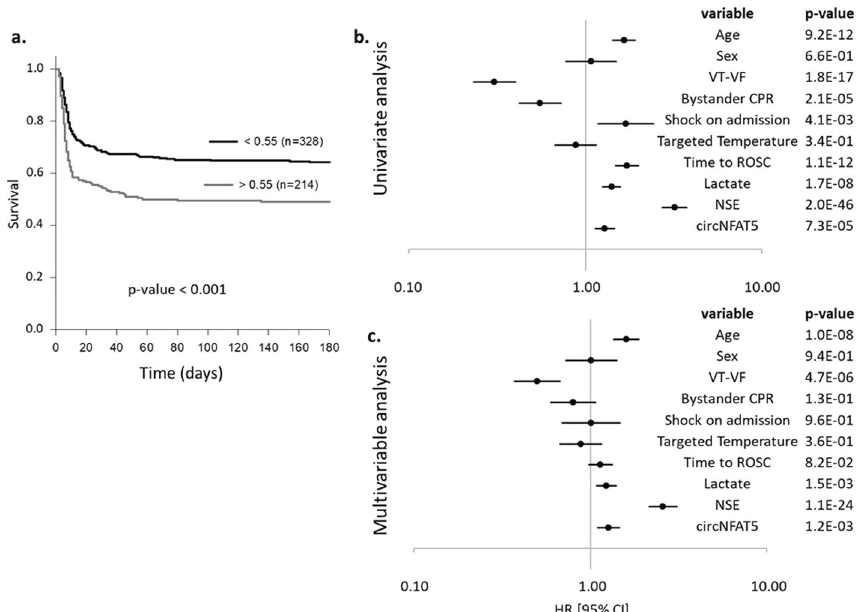
Fig. 5 Survival analyses in TTM‑trial patients at 6 months. 6‑month survival of TTM‑trial patients using Kaplan–Meier curves and Cox proportional hazards. a Kaplan–Meier curves using the Youden’s index as cut‑off value. b Univariate Cox proportional hazards for 9 independent variables and circNFAT5. c Multivariable Cox proportional hazards model. Data are presented as hazards ratio (HR) with confidence interval [95% CI] and p ‑values are indicated for each variable